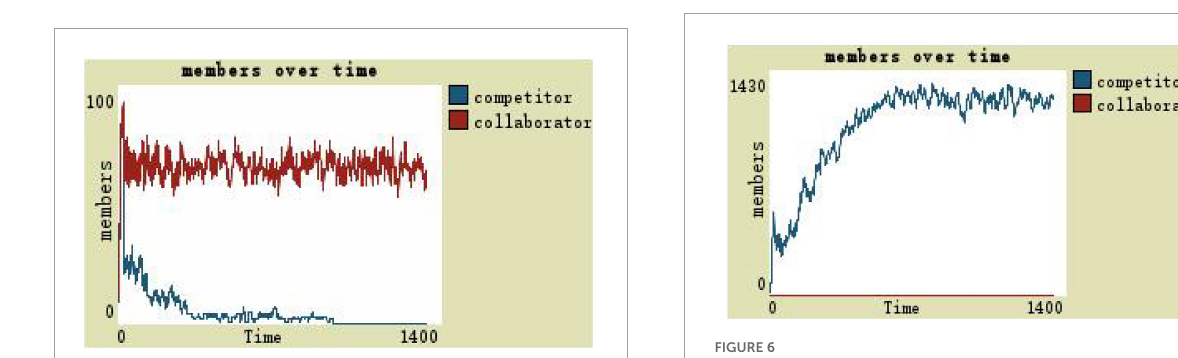
FIGURE6 Team members change with the low level of trust.